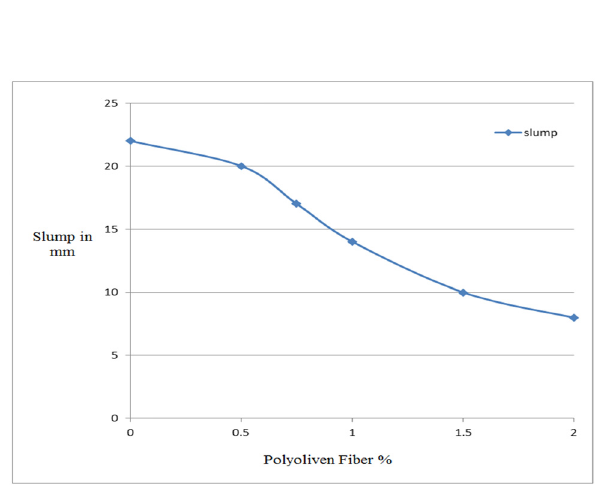
Table 9: Compressive strength of concrete containing polyole fi n